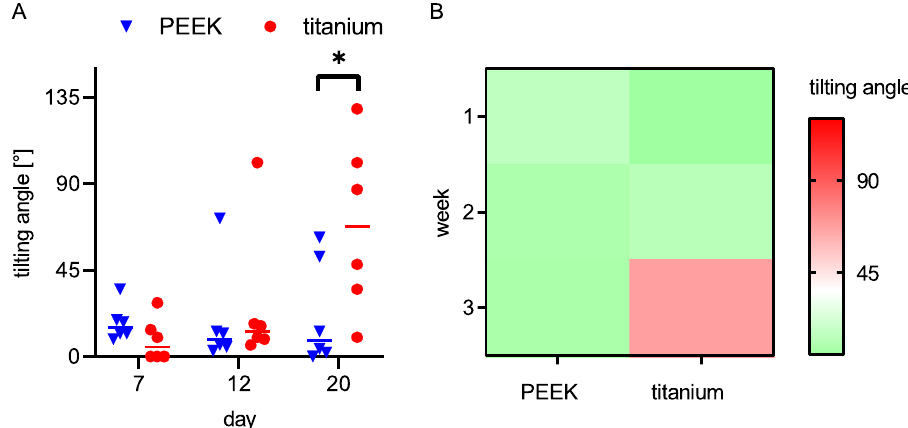
Figure 3. Lateral chamber tilting. PEEK and titanium chamber tilting angles over time are given as individual values ( A ) and as a heatmap indicating high risk for lateral chamber tilting ( B ). PEEK chambers significantly reduced lateral tilting in the third week, while tilting in both chambers was comparable for 12 days. This is further visualized in the heat map ( B ). Differences between the groups were analysed by multiple t-tests (Holm- Sidak), *p < 0.05, PEEK: n = 6, titanium: n = 6.